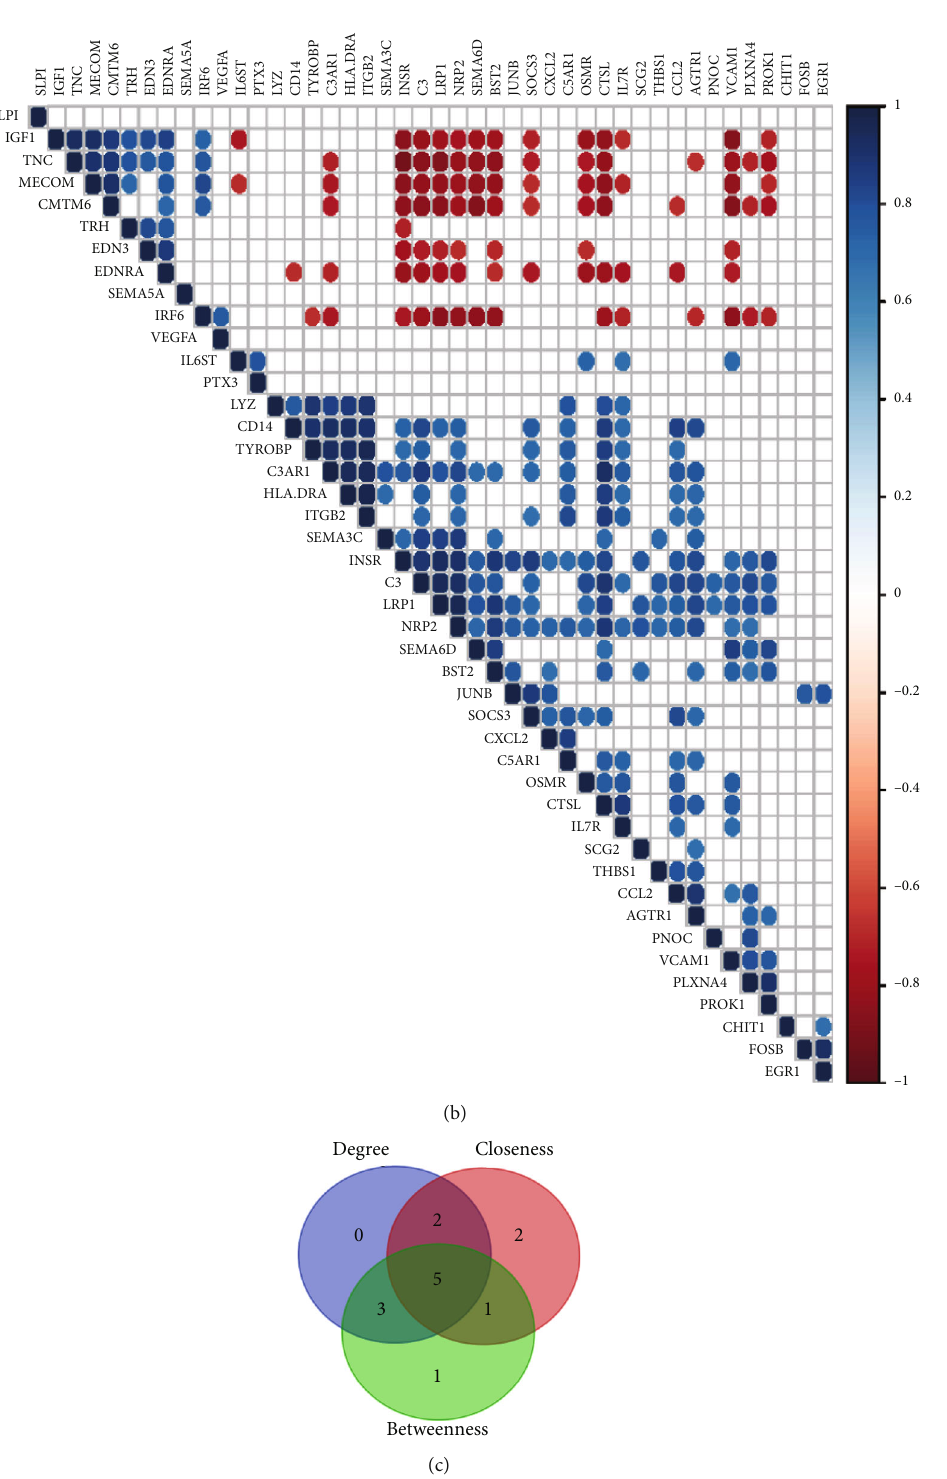
Figure 12: PPI network, modules, and identi fi cation of 5 hub genes. (a) The PPI network of the 94 DETFs and 111 DEIRGs (interaction score > 0 : 9 ). Blue nodes represent transcription factors, and green nodes represent immune-related genes. (b) The correlation of DETFs and DEIRGs ( P < 0 : 001 ). (c) Venn diagram showing the overlap of the top ten nodes in topological features of degree, betweenness, and